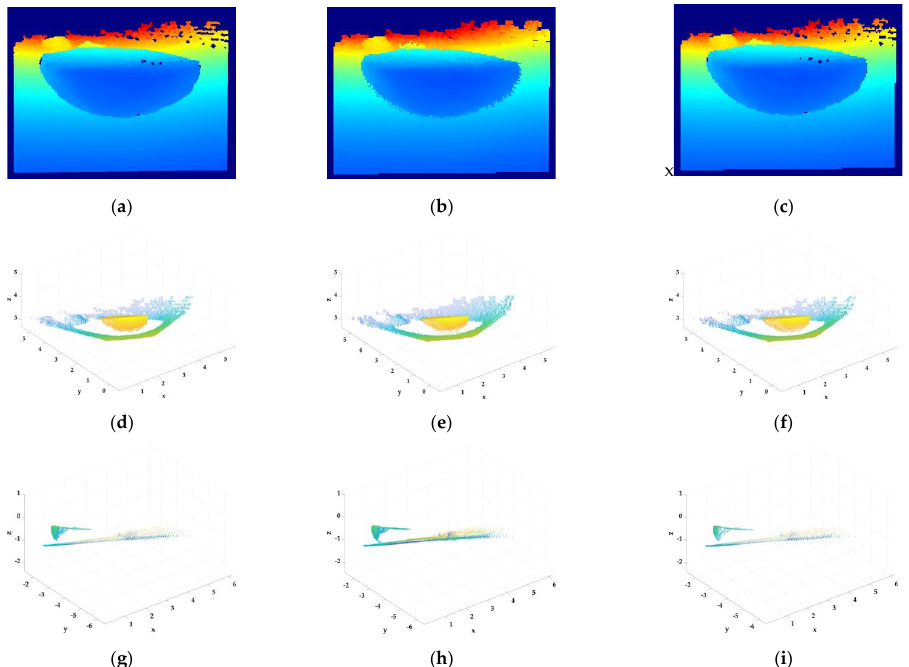
Figure 15. Validation of fractional-order differential Kriging interpolation super-resolution model (dataset no. 03236). ( a , d , g ) Original depth images; ( b , e , h ) Outputs of fractional-order differential Kriging interpolation super-resolution model ( ν = 0.6, PSNR = 32.290 dB); ( c , f , i ) Outputs of nearest- neighbour interpolation super-resolution model (PSNR = 23.383 dB).